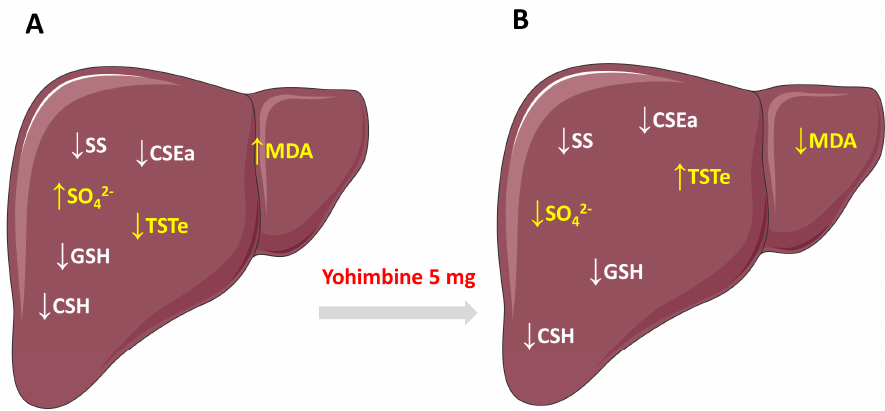
Figure 9. Graphic illustration of the changes in the level of thiols, cysteine catabolism, and lipid peroxidation induced by HFD in the rat liver ( A ) and the effect of yohimbine administered at a dose of 5 mg/kg/day for 30 days ( B ). Arrows indicate: ↑ —increase; ↓ —decrease. SS—sulfane sulfur,